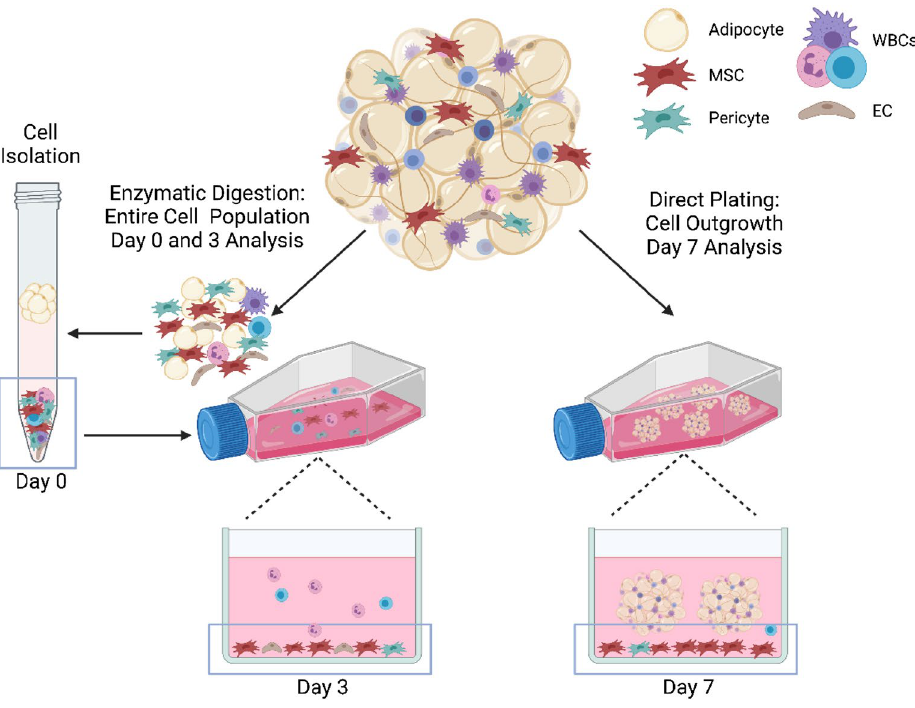
Figure 1. Schematic demonstrating cell population isolated and characterized from MFATs. Enzymatic dissociation was used to isolate a cell pellet for initial (Day 0) and early culture (Day 3) analysis. Direct plating of MFAT was used to evaluate cell outgrowth from the tissue (Day 7). Figure created with www. BioRe nder. com.